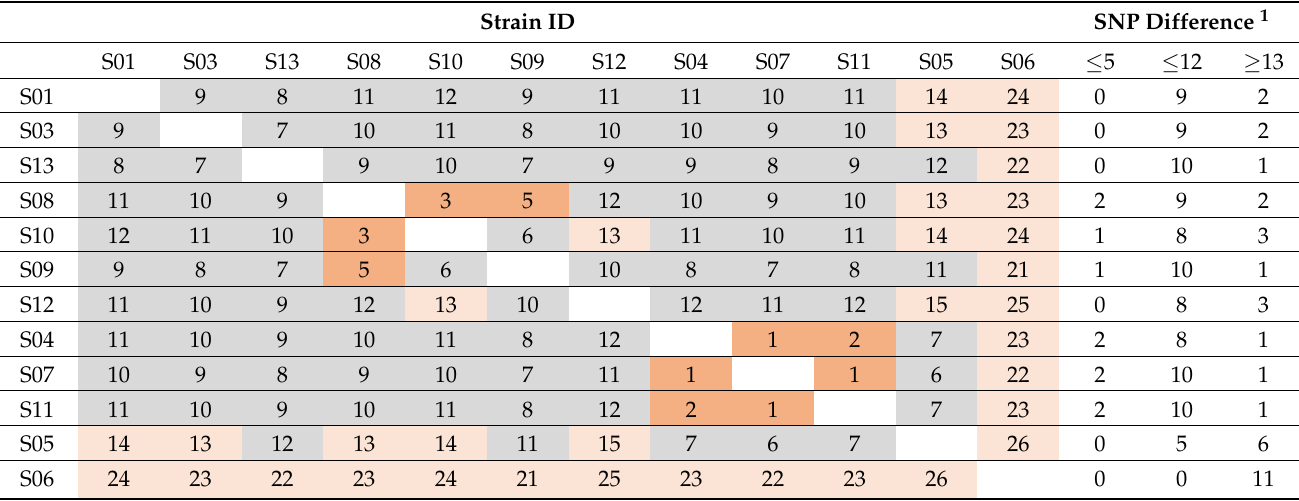
Legend: ≤ 5 SNPs; ≤ 12 SNPs; ≥ 13 SNPs. 1 Number of strains differing by ≤ 5, ≤ 12, and ≥ 13 SNPs to an individual strain. The letter S before the ID stands for strain. Boxes are highlighted according to the SNP differences as shown in the legend.